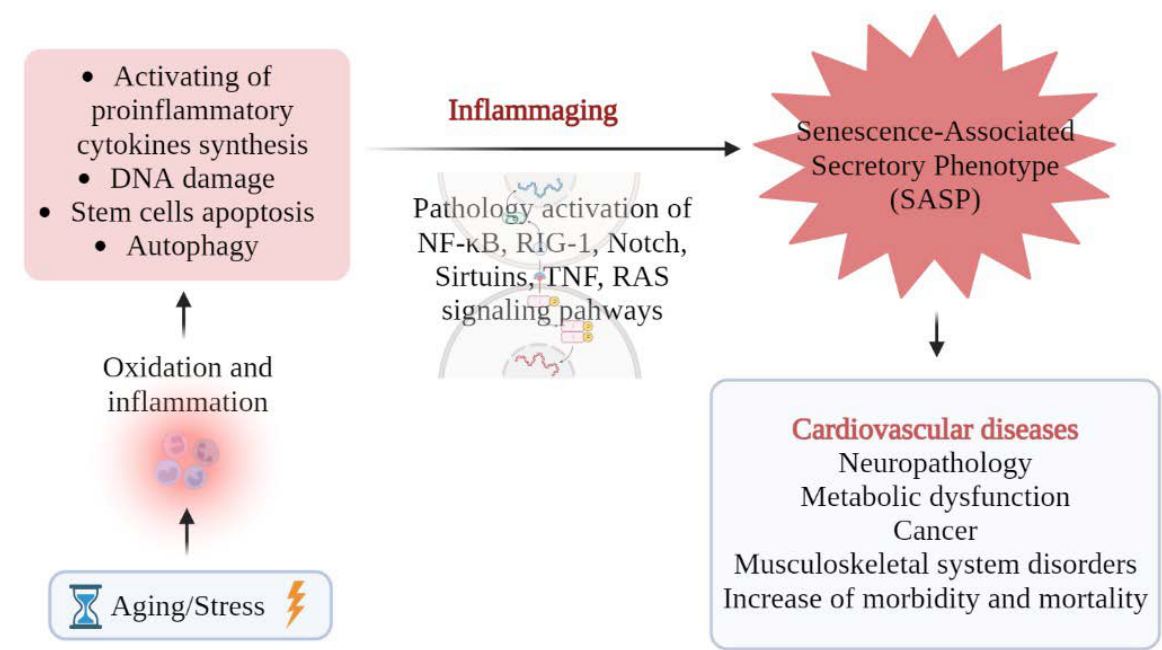
Figure 1. SASP, inflammaging and age-associated diseases.